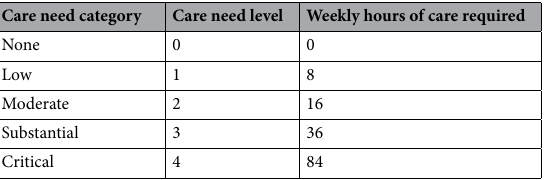
Table 2. Care need categories/levels and number of hours of care